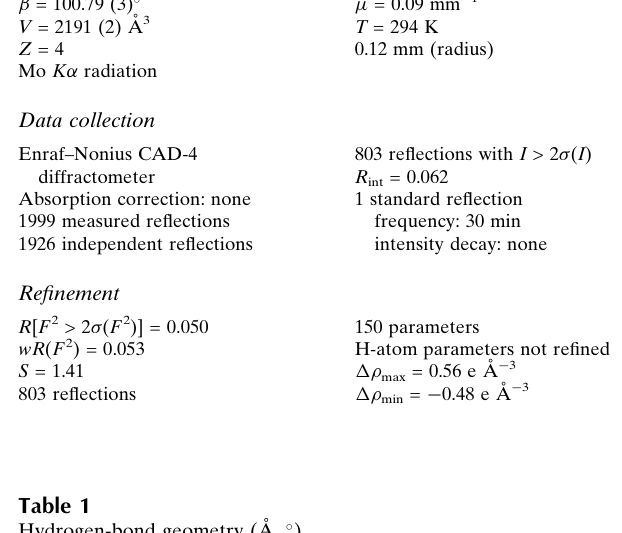
Hydrogen-bond geometry (A˚ , (cid:2)